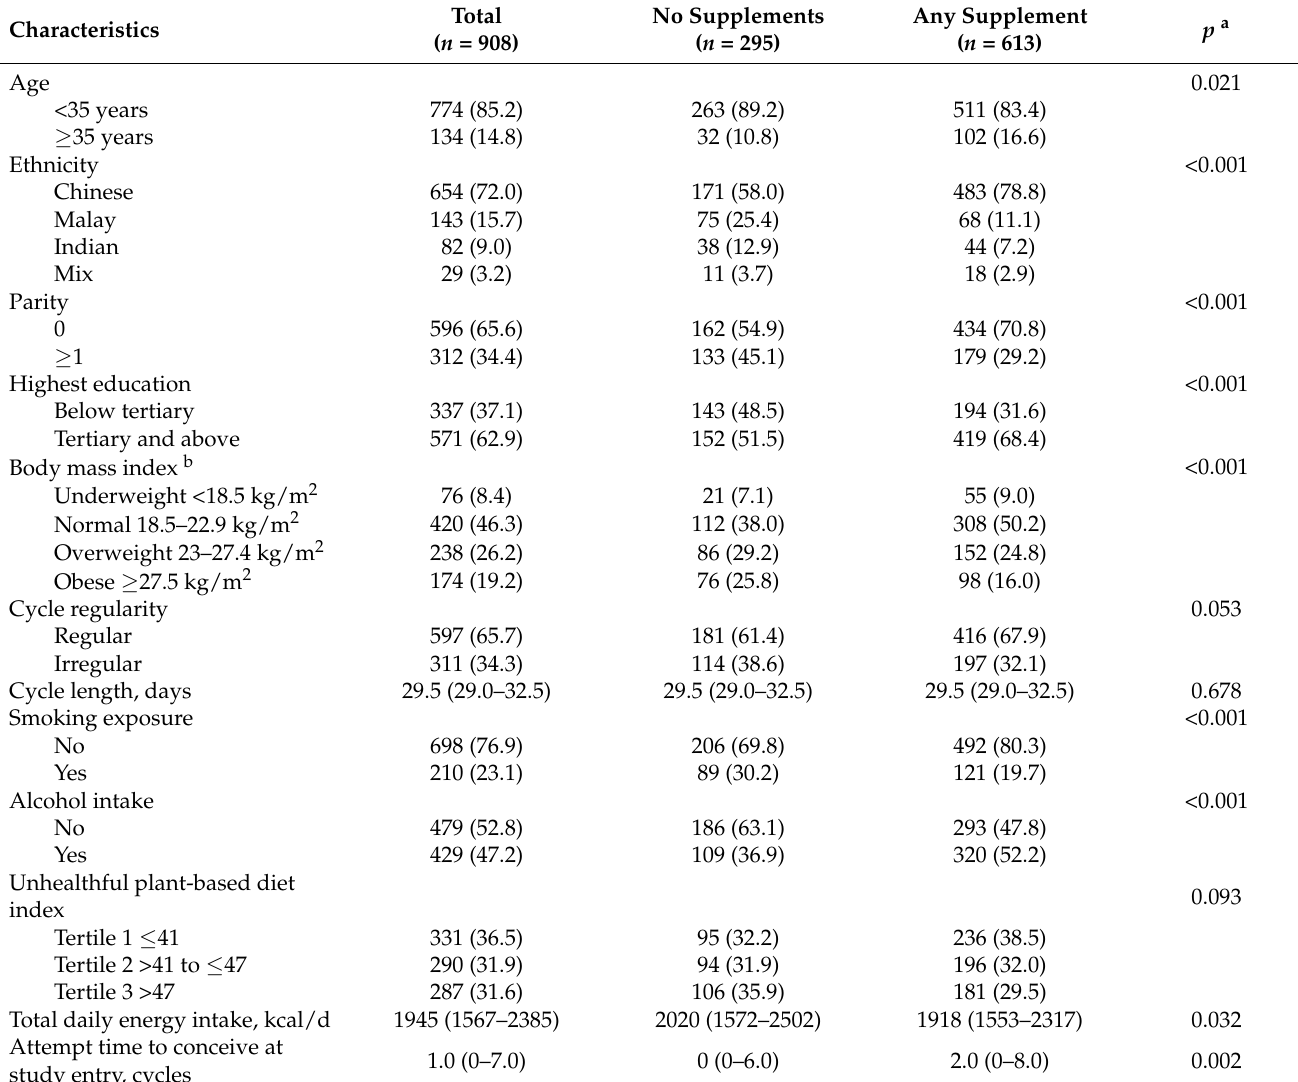
Table 1. Characteristics of women according to supplement intake status in the last 3 months from the S-PRESTO study, 2015–2018 ( n =